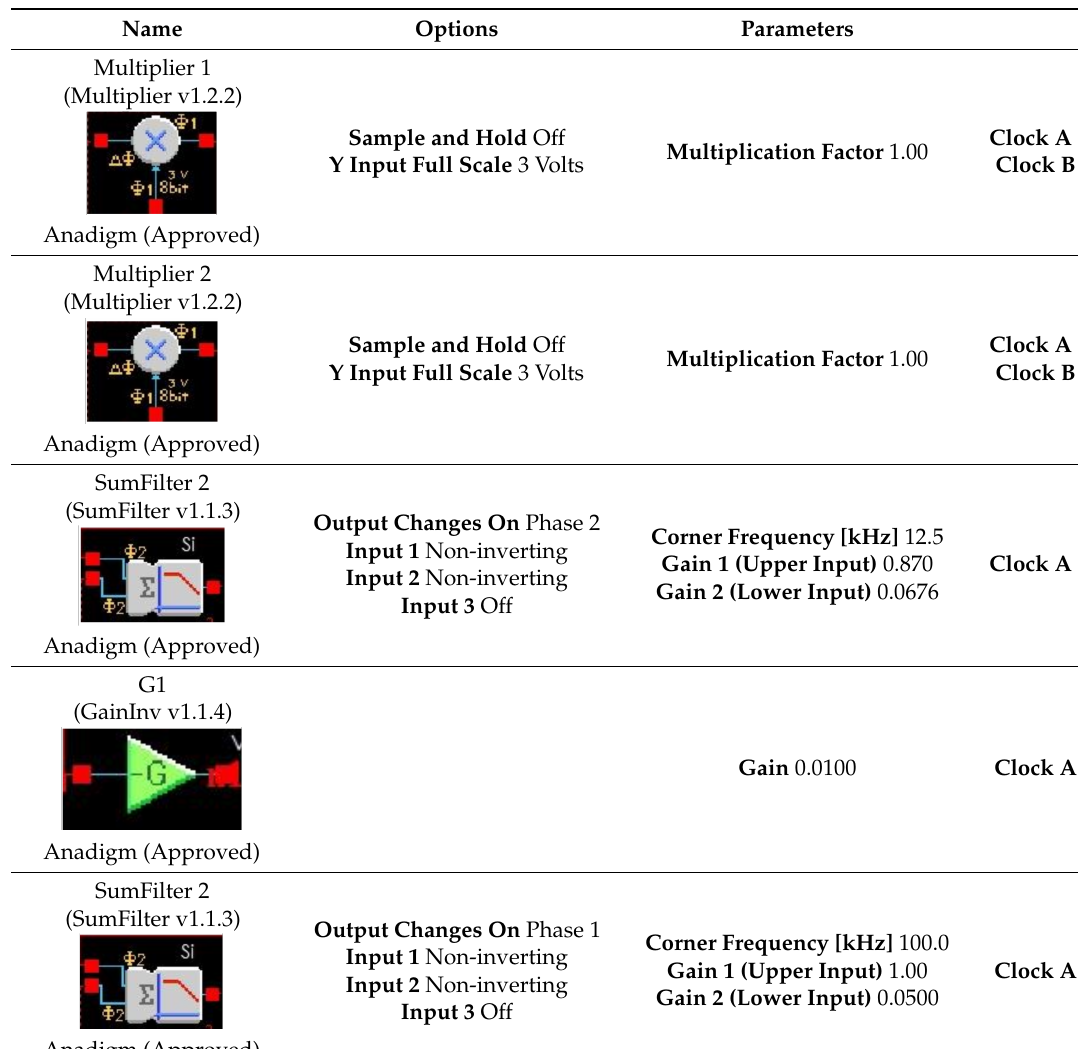
Table 1. FPAA emulator parameter